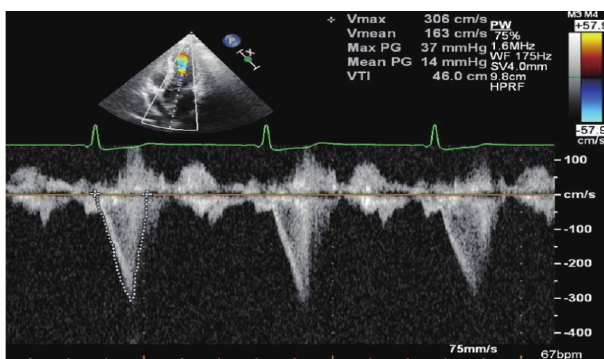
Figure 5 Apical five-chamber view: the blood flow velocity of LVOT increases during systole with the peak velocity of 3.1m/s and the maximum pressure difference is 37mmHg, the blood flow spectrum is negative high- velocity filling jet during systole, and the shape presents as single-peaked "dagger-like" change.